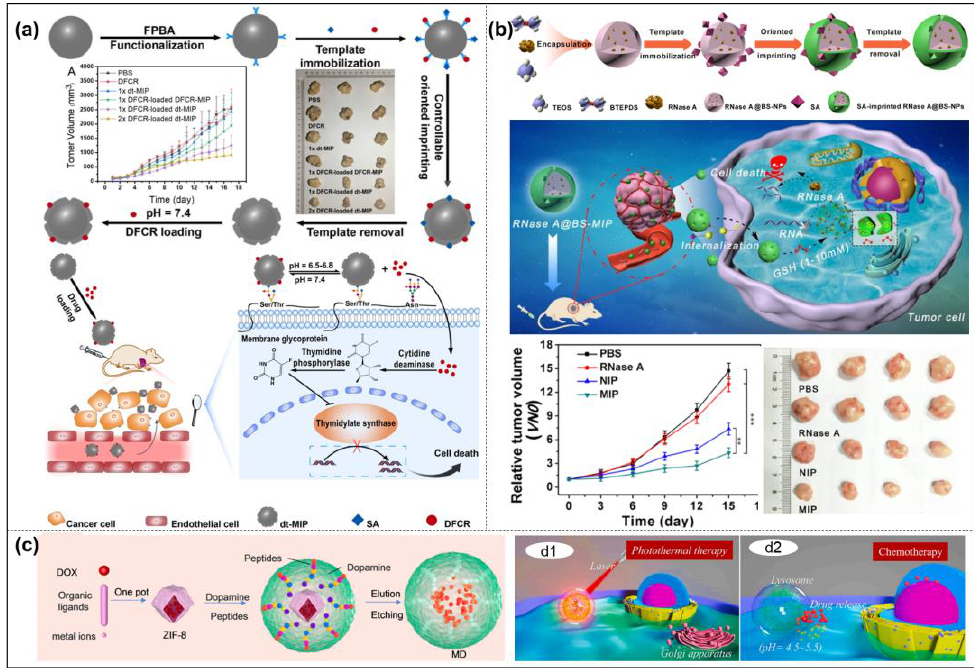
Figure 12. Schematic of the drug transport and action mechanism in the dual-templated MIP-based smart prodrug delivery system. Representative photographs of mice in different groups after treatment for 18 days and mean tumor volume ( a ); illustration of SA-imprinted MIP-NPs applied for transport in blood vessels, tumor targeting, cellular uptake, and sequential GSH-triggered degradation along with cargo release. ** p < 0.01, *** p < 0.001. ( b ); the detailed synthetic procedure of MIP-NPs, and chemo-photothermal synergistic anti-cancer therapy ( c ). Reprinted with permission from Ref. [81,156,157]. Copyright 2020, Wiley; 2021, ACS; 2021, Elsevier.